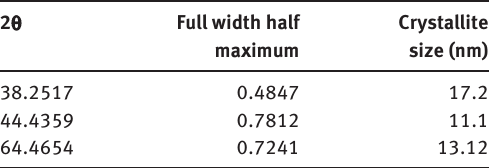
Table 3 Crystallite size of gold nanoparticles calculated using Scherrer’s